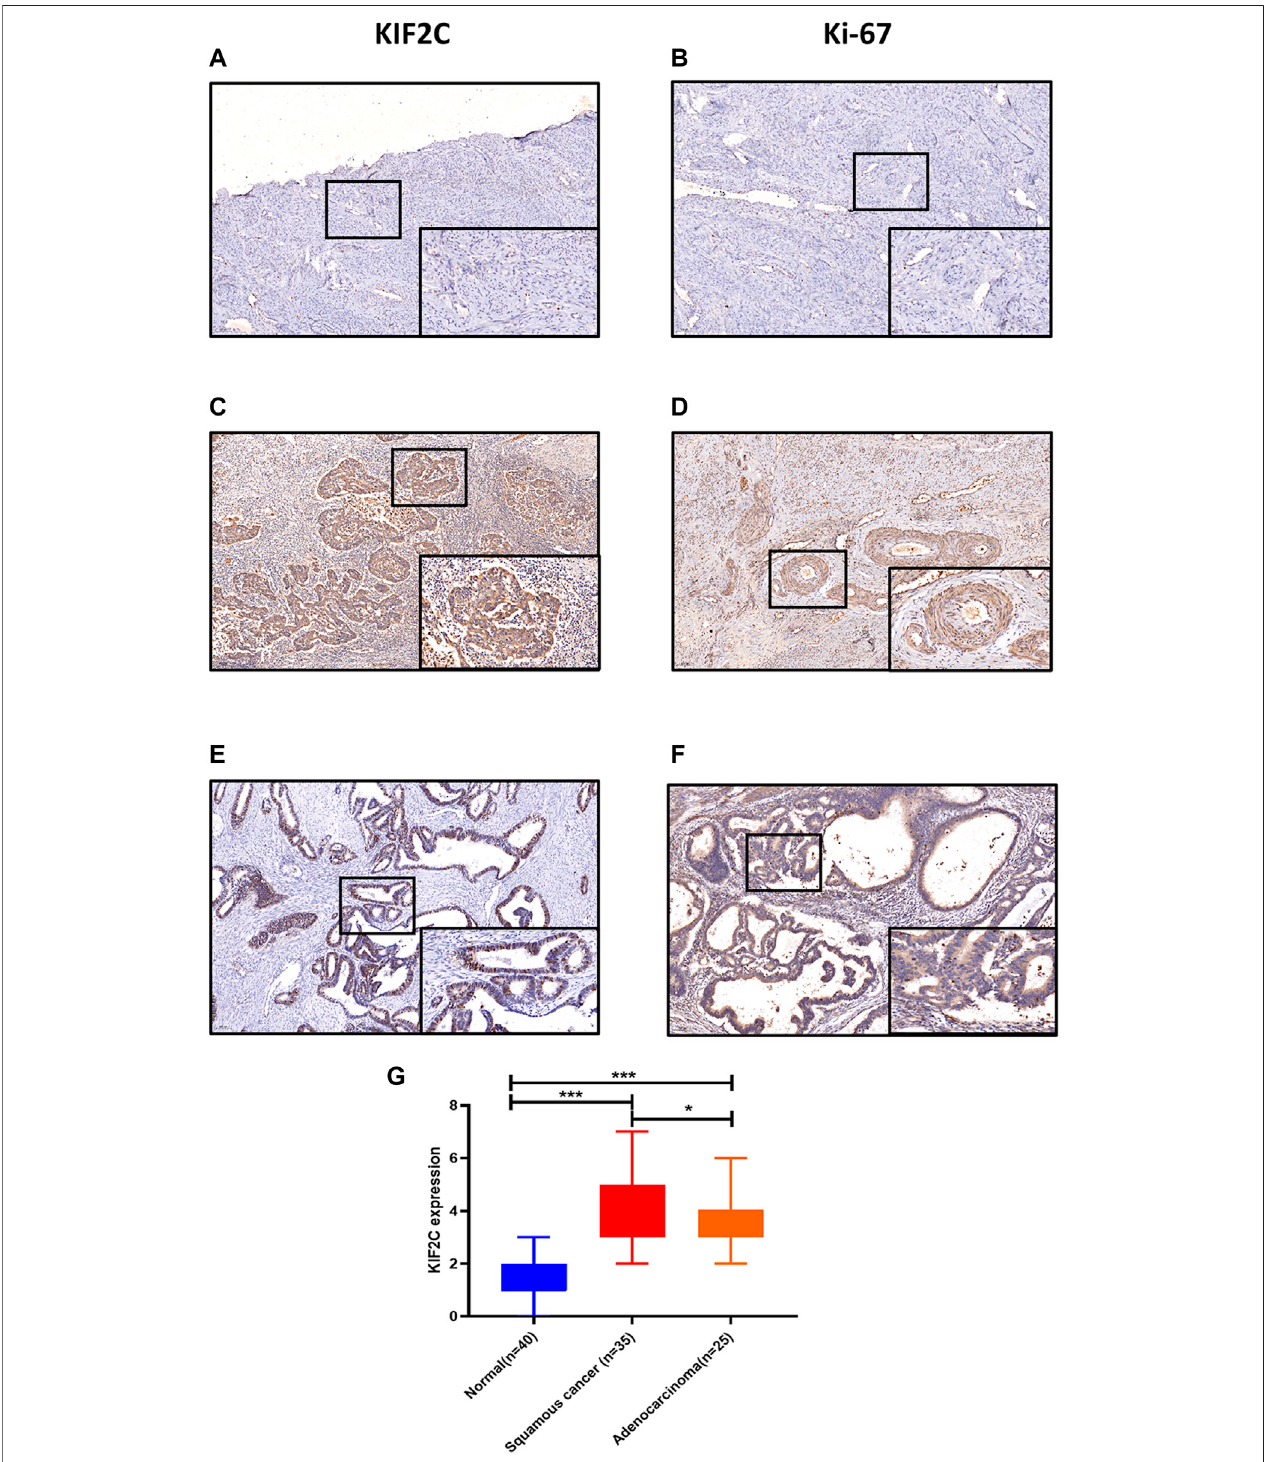
FIGURE 5 | KIF2C was highly expressed in cervical cancer tissues. (A, B) Immunohistochemical staining of KIF2C and Ki-67 in normal cervical tissues. (C, D) Immunohistochemical staining of KIF2C and Ki-67 in cervical squamous cell carcinoma tissues. (E,F) Immunohistochemical staining of KIF2C and Ki-67 in cervical adenocarcinomatissues.(Insets)Regionswithhighermagni fi cation. (G) ImmunohistochemicalintensityscoresofKIF2Cstainingin100specimens.* p < 0.05,** p < 0.01; *** p < 0.001.